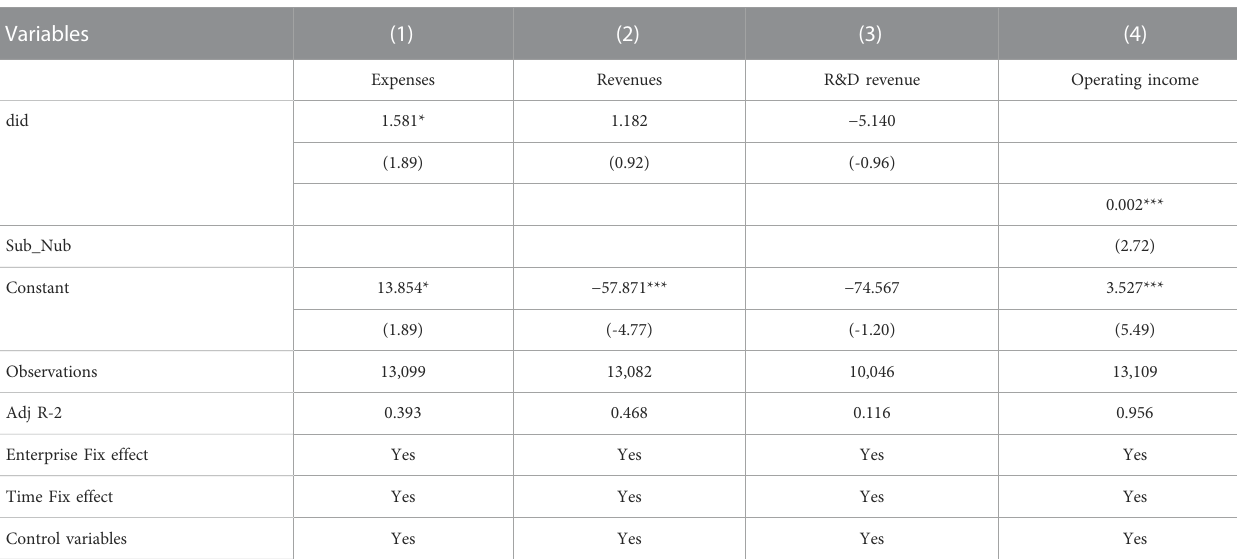
TABLE 4 Mechanism